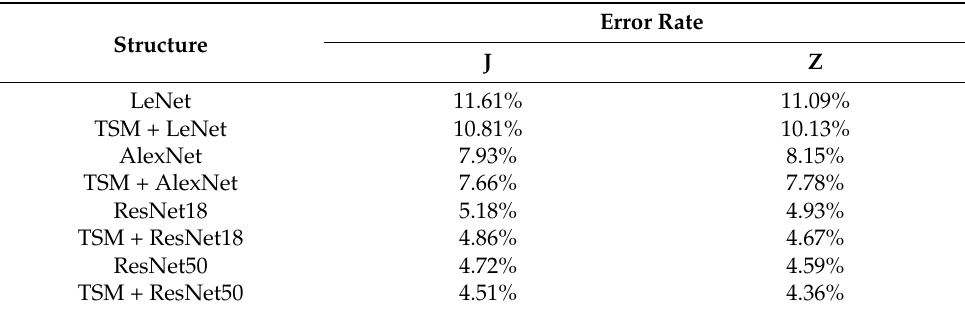
Table 7. Results of Comparing J and Z in ASL